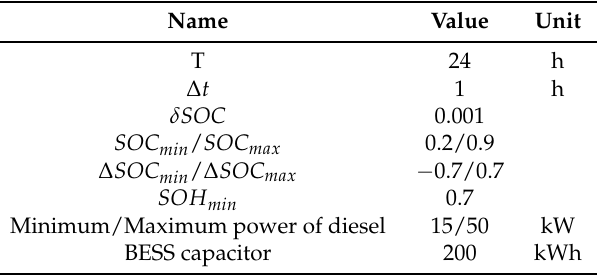
Table 1. The simulation parameter values.